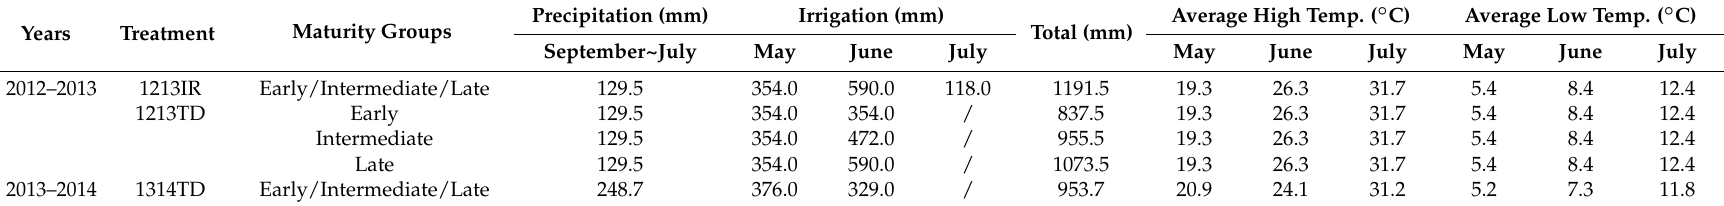
Table 7. Description of the test